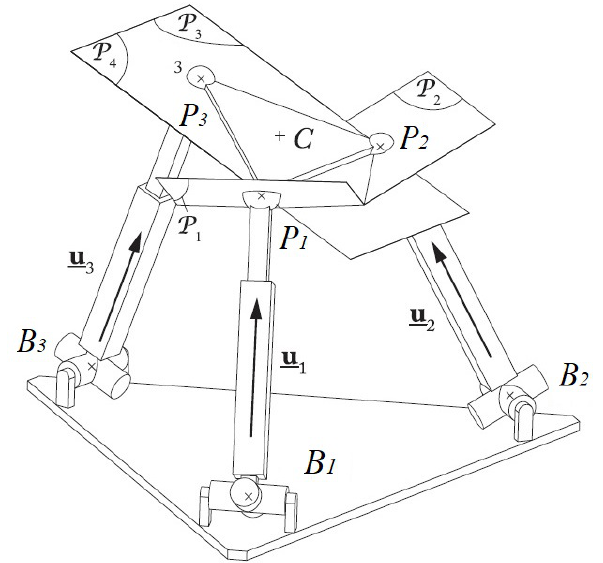
Figure 6. Example of a Type 2 singularity for a 3- UPS robot: the platform gets an uncontrollable rotation around P 1 P 2